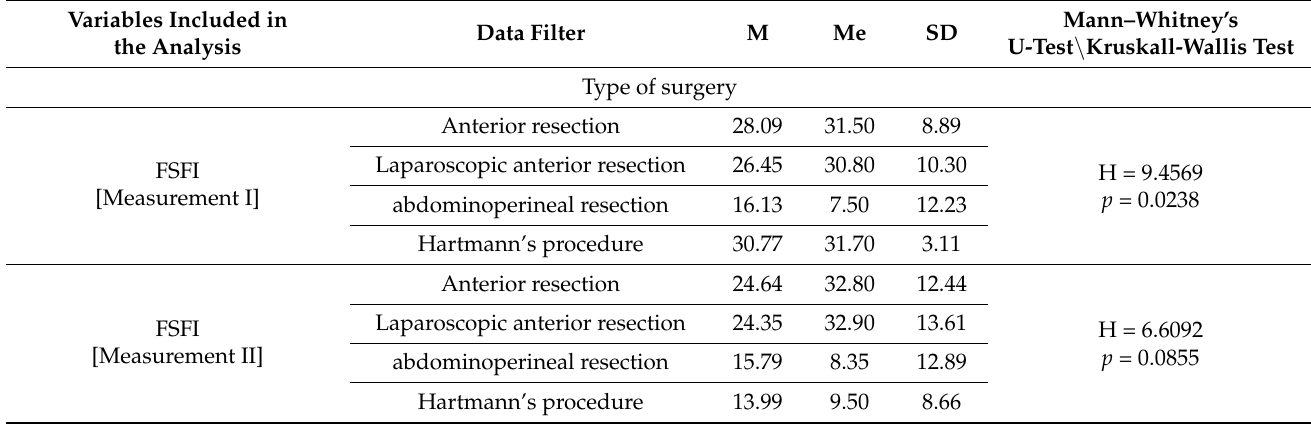
Table 6. Correlation between FSFI scores and qualitative clinical and demographic